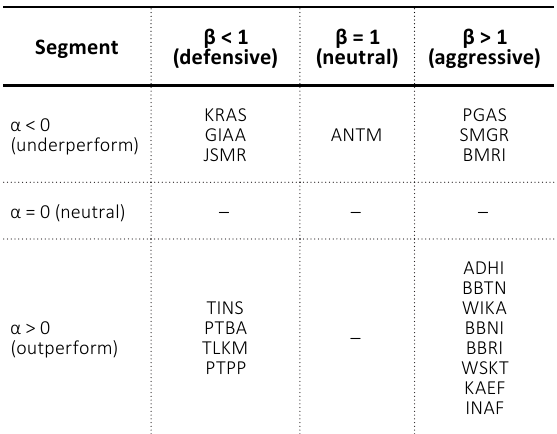
Table 4. The segmentation of equity